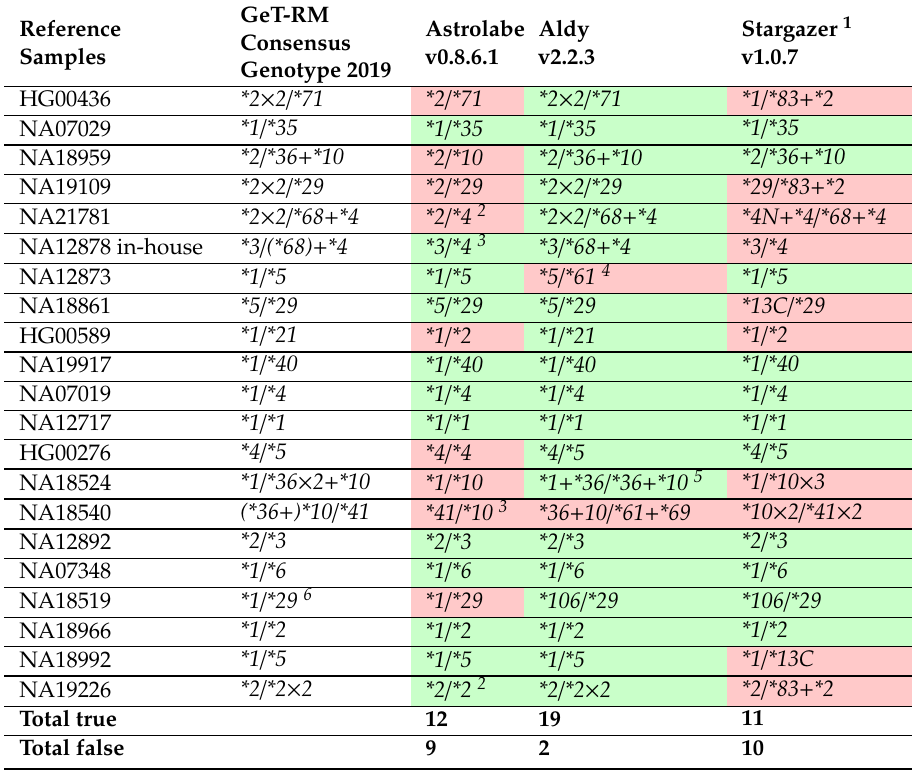
Table 2. Comparison of CYP2D6 callers output, in form of star alleles (single nucleotide variants, small insertions / deletions, structural variations), from 21 publicly available short-read WGS